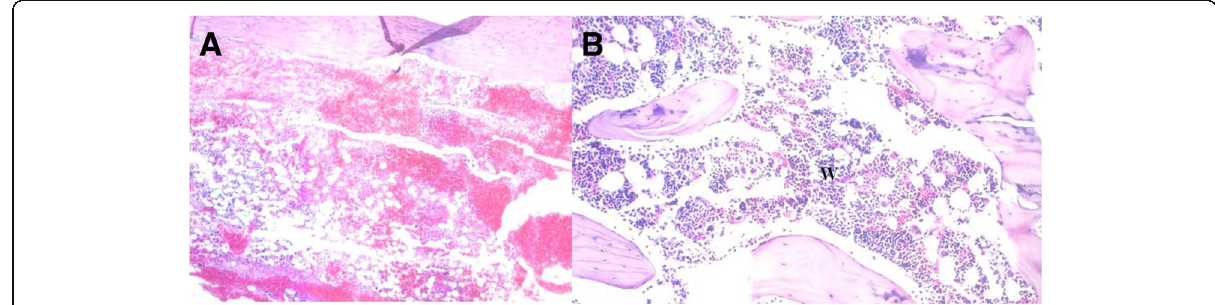
Fig. 1 Hematoxylin- and eosin-stained histological sections of Control group. a A large blood clot was revealed within the within the first hours (X40). b After 15 days, the marrow cavity was filled with woven bone and trabecular bone